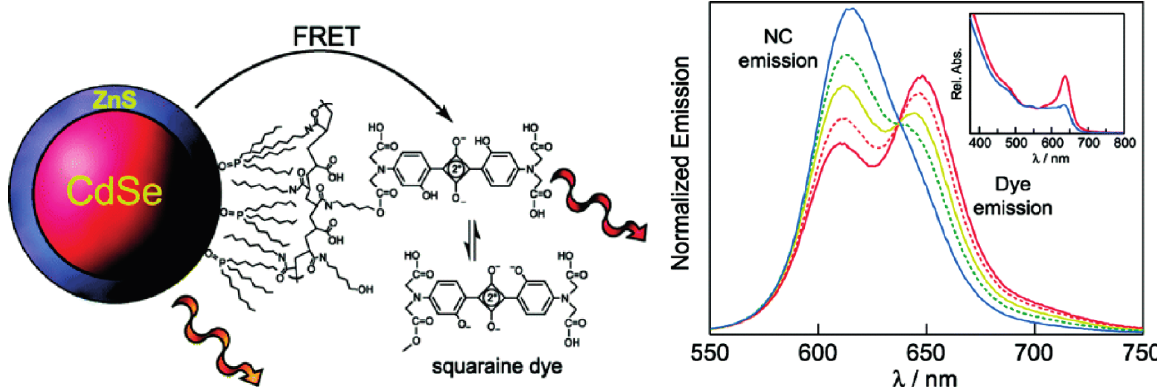
Figure 6. Schematic illustration of the sensor construction and the pH-dependent emission profiles. The squaraine absorption suppression in basic condition is shown in the inset (Reprinted with permission from [88], Copyright 2006 American Chemical